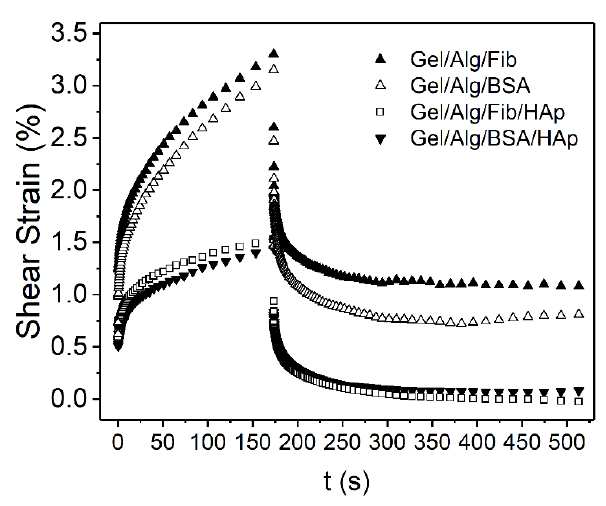
Figure 9. Creep-recovery curves of the four studied samples.